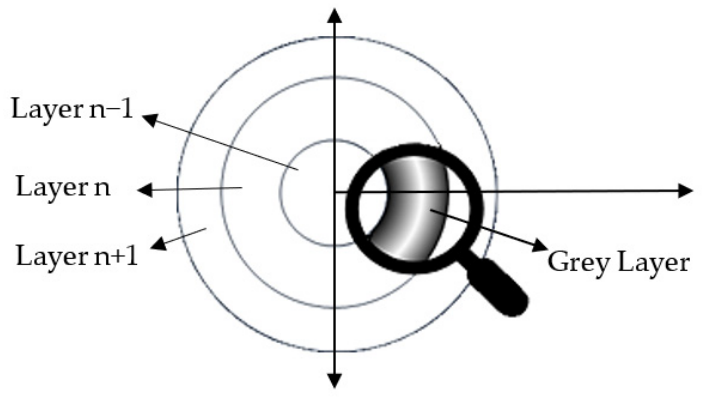
Figure 5. Grey layer. In grey theory, the membership function is defined as Equation (2) and needs to be included in the family membership (FM) sequence.